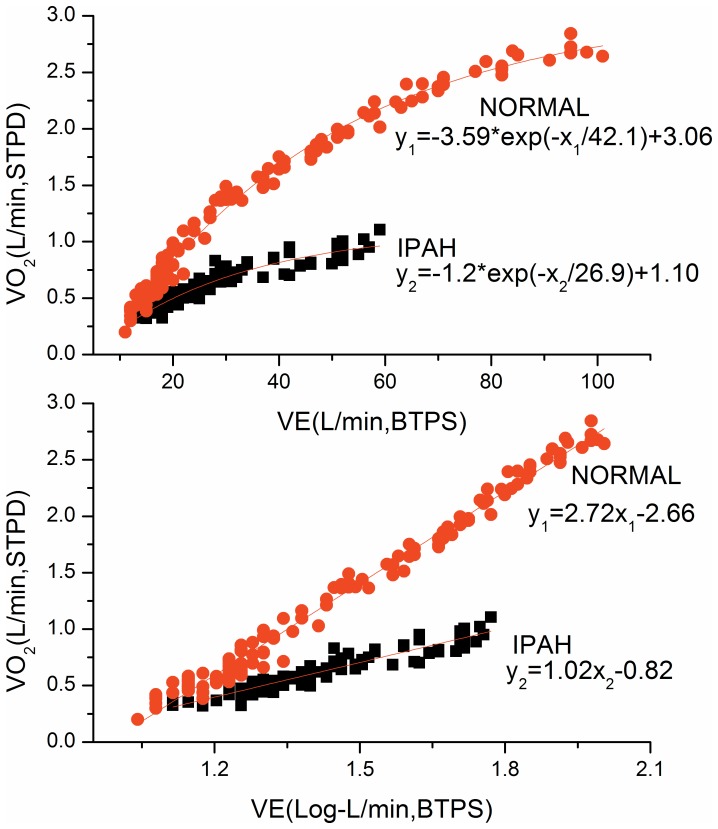
Difference of OUES between a typical IPAH patient and a control subject.Linear (upper panel) and single-segment logarithmic (lower panel) relation between V˙O2 (ml/min) and V˙E (ml/min) for 2 different subjects. Steeper slopes represents more efficient oxygen uptake. The control subject (steeper slopes, aged 24 years; height, 158 cm; weight, 45 kg), has an oxygen uptake efficiency slope (OUES) of 2.72 whereas the IPAH patient (shallower slopes, aged 21 years; height, 161 cm; weight, 47 kg) has an OUES of 1.02.